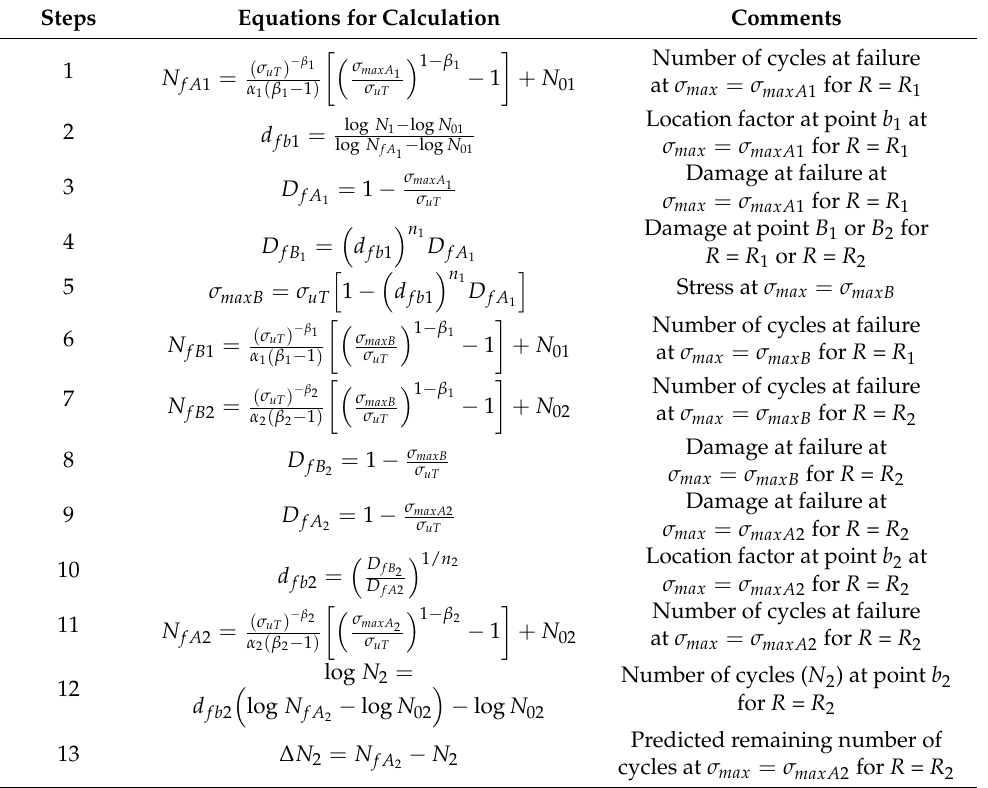
Table 1. Sequence of calculations for predicting the remaining fatigue life in volving two stress